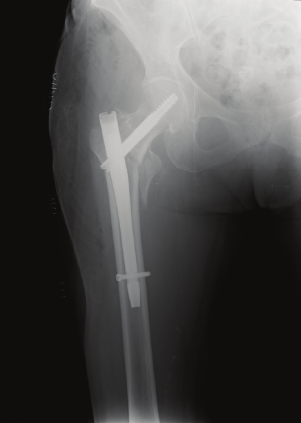
Figure 3: The AP view radiograph of the right hip demonstrates proximal migration of the lesser trochanter.